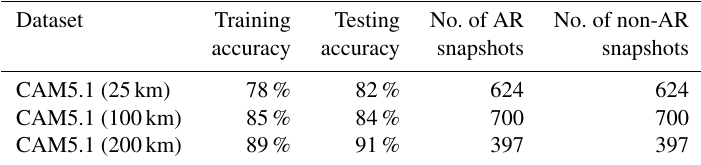
Table 4. Classification accuracy score estimated by the SVM classifier for daily temporal resolution of the CAM5.1 model with three different spatial resolutions. The table also shows the number of snapshots (number of events for both categories: ARs and non-ARs).